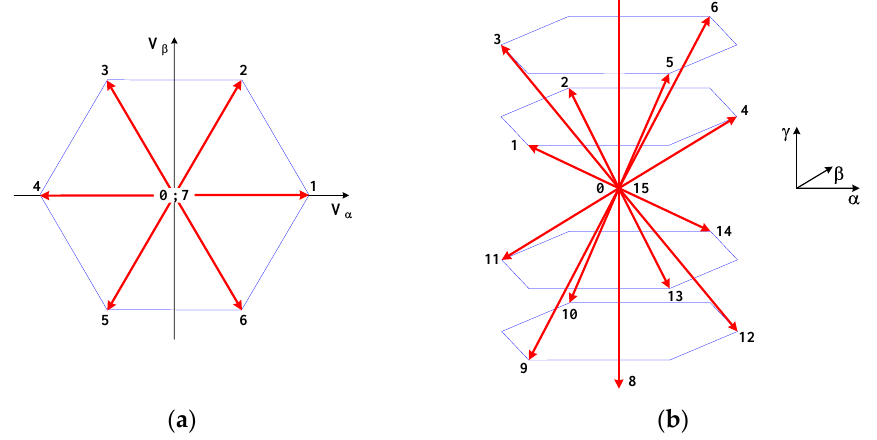
Figure 3. Voltage Vectors for the: ( a ) three-leg converter ( b ) four-leg converter.